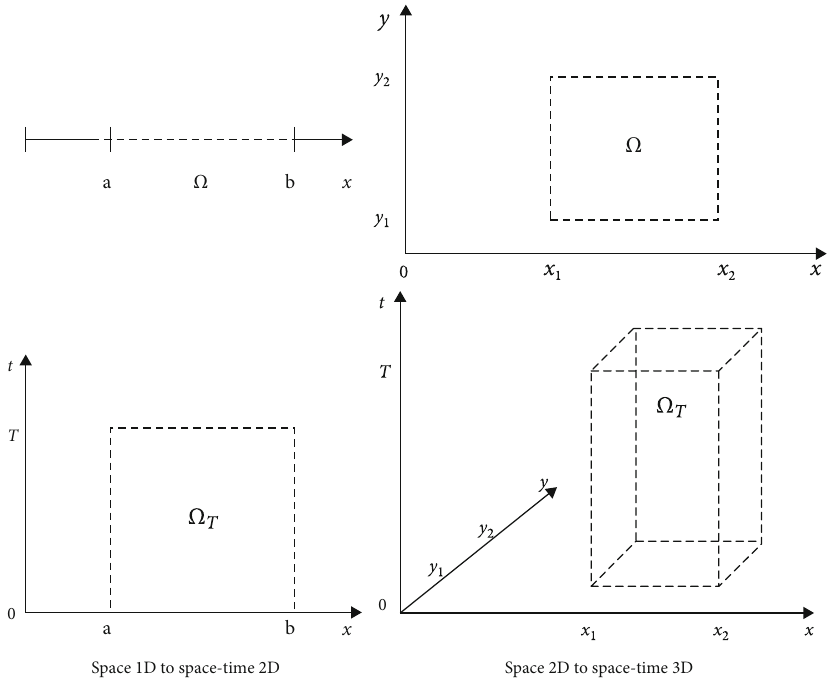
Figure 1: Space-time domain